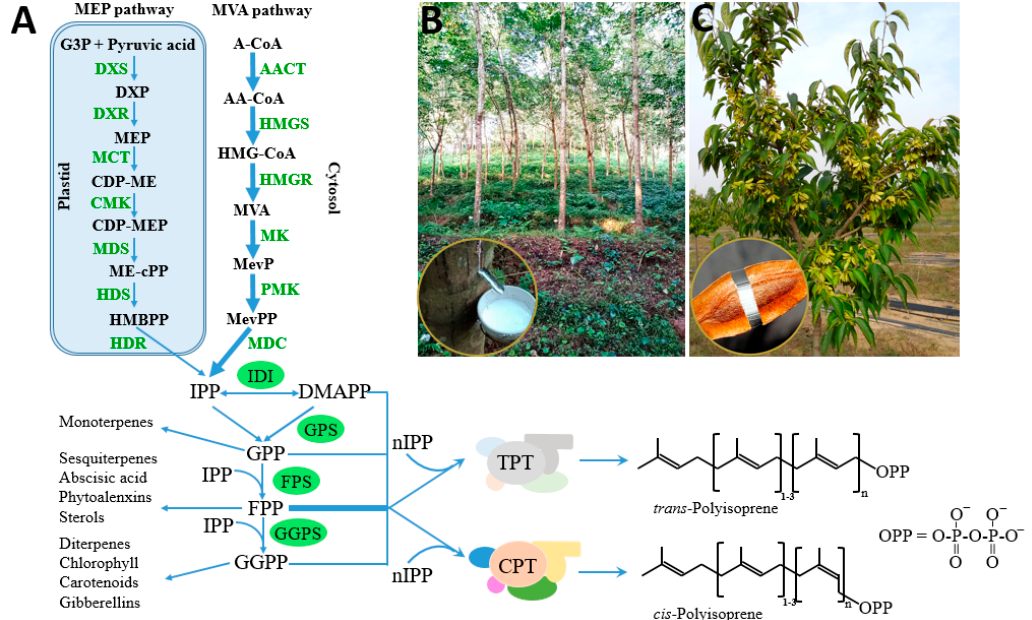
Figure 1. Biosynthesis of natural rubber and trans -polyisoprene and the related isoprenoid pathway. ( A ) Biosynthetic pathway of natural rubber and trans -polyisoprene, and the related 2-C-methyl-D-erythritol-4-phosphate (MEP), mevalonate (MVA) and the oligomeric allylic pyrophosphates synthetic pathway, “n” depends on species [2]; ( B ) the exclusively commercial cis -polyisoprene producing plant—Para rubber tree Hevea brasiliensis , with the lower left picture showing rubber tapping; ( C ) the trans -polyisoprene producing plant—hardy rubber tree Eucommia ulmoides , with the lower left picture showing trans -polyisoprene containing in its fruit [5]. Intermediates in MEP pathway: G3P, glyceraldehyde-3-phosphate; DXP, 1-deoxy- D -xylulose-5-phosphate; MEP, 2-C-methyl- D -erythritol-4-phosphate; CDP-ME, 4-(cytidine-5 (cid:48) -diphospho)-2-Cmethyl- D